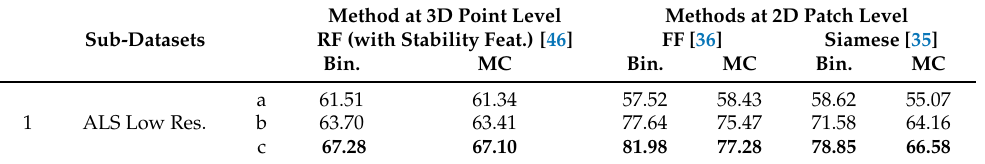
Table 5. Results of different supervised methods with varying training set sizes (training sets of sub-dataset 1a., 1b. and 1c. contained, respectively, 1, 10 and 50 simulations). Means of IoU over classes of change are given (%). Bin. stands for binary classification results, MC for multi-class classification results, Res. for resolution. For each types of results best values are shown in bold. Method at 3D Point Level Methods at 2D Patch Level Sub-Datasets RF (with Stability Feat.) [46] FF